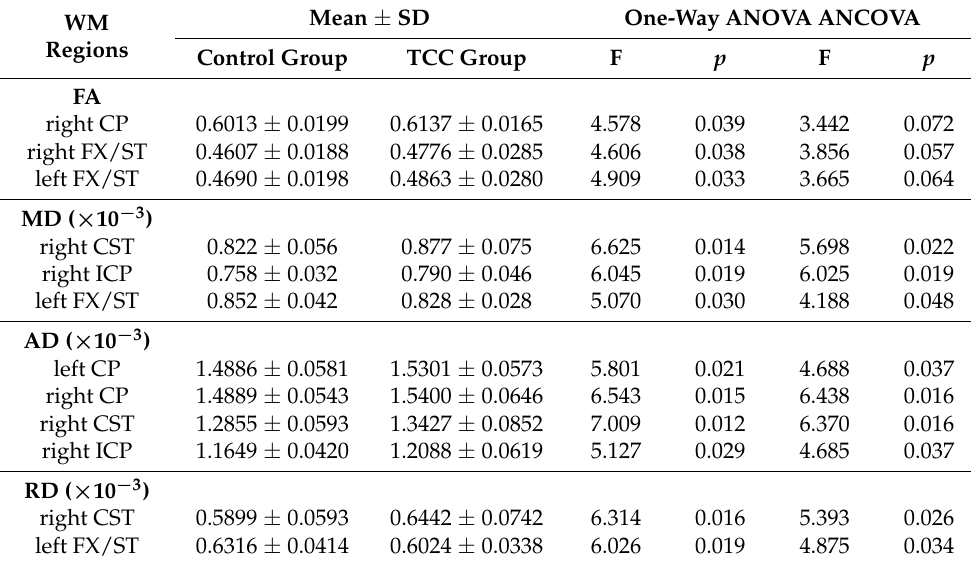
Table 2. Differences in diffusion metrics for specific WM